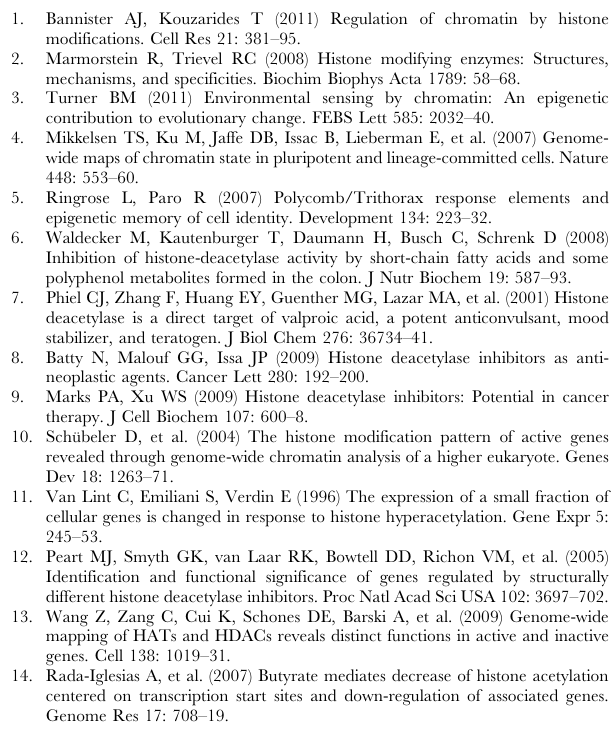
Table S1 Primers used to assess changes in gene expression. Forward (F) and reverse (R) sequences are listed along with their melting temperatures (Tm). For some genes, more than one primer pair was used. Table S2 Primers used for chromatin immunoprecipitation analysis. Forward (F) and reverse (R) primer sequences are listed along with melting temperatures